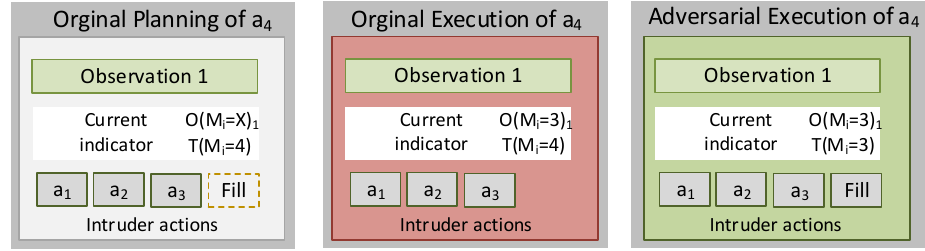
Figure 3. Locality-based mimicry by noise